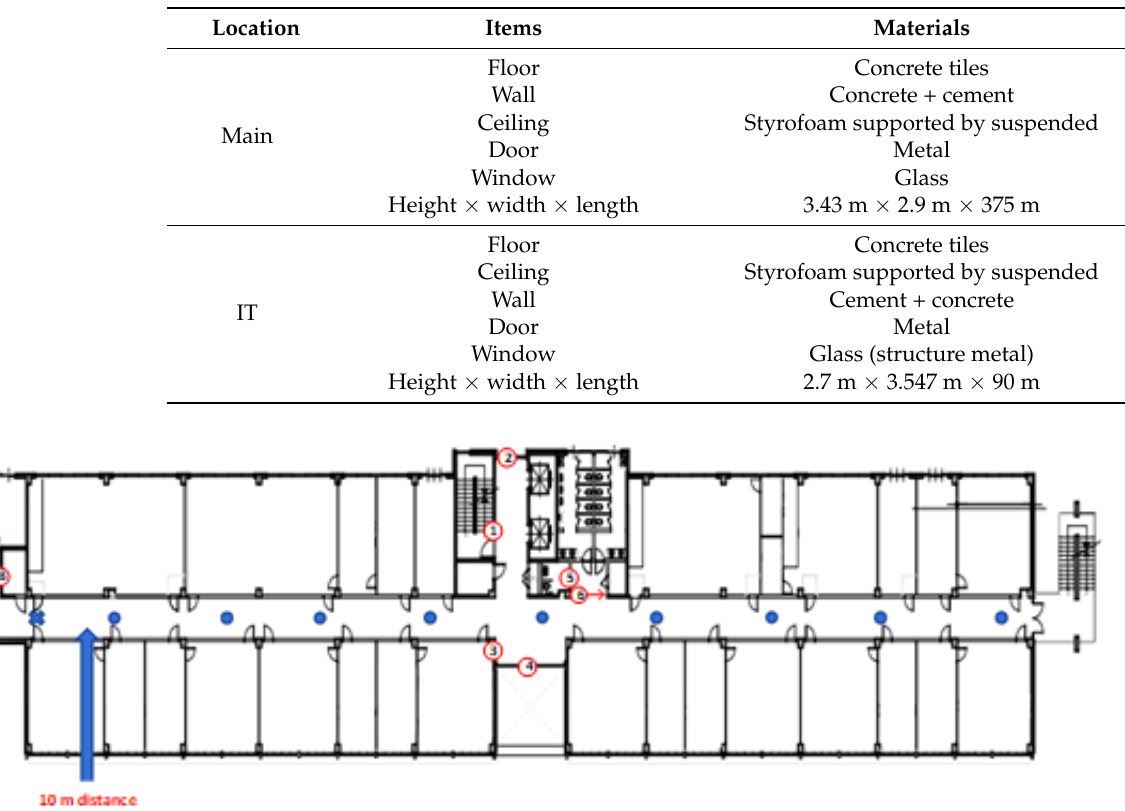
Figure 2. Measurement locations of the transmitter and receiver during the campaign. There are some structural changes in the corridor. These 2-dimensional changes of such spaces are marked with circled numbers and the length of the irregularities are: 1 (cid:13) 8.894 m; 2 (cid:13) 2.950 m; 3 (cid:13) 1.540 m; 4 (cid:13) 6.55 m; 5 (cid:13) 2.322 m; 6 (cid:13) 3.162 m; 7 (cid:13) 1.371 m; and 8 (cid:13) 3.267 m.